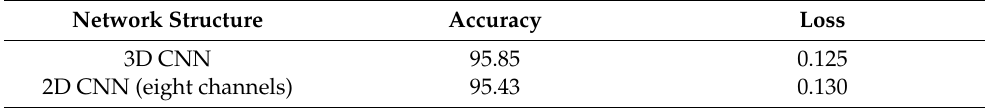
Table 3. Accuracy and loss of the two networks using range–doppler as